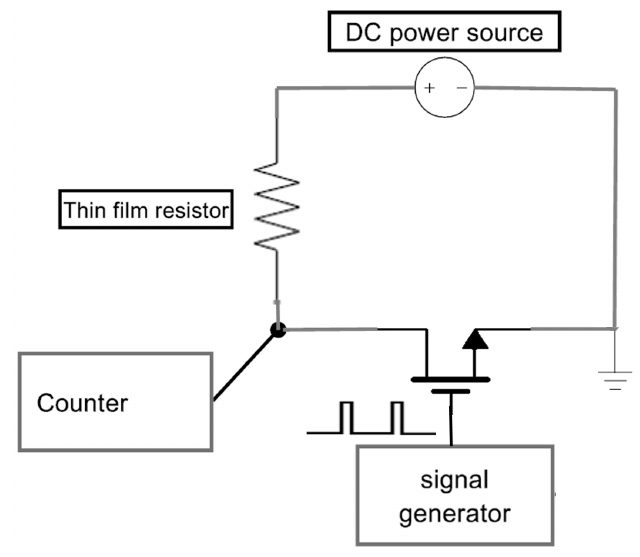
Figure 5. Experiment setup diagram.